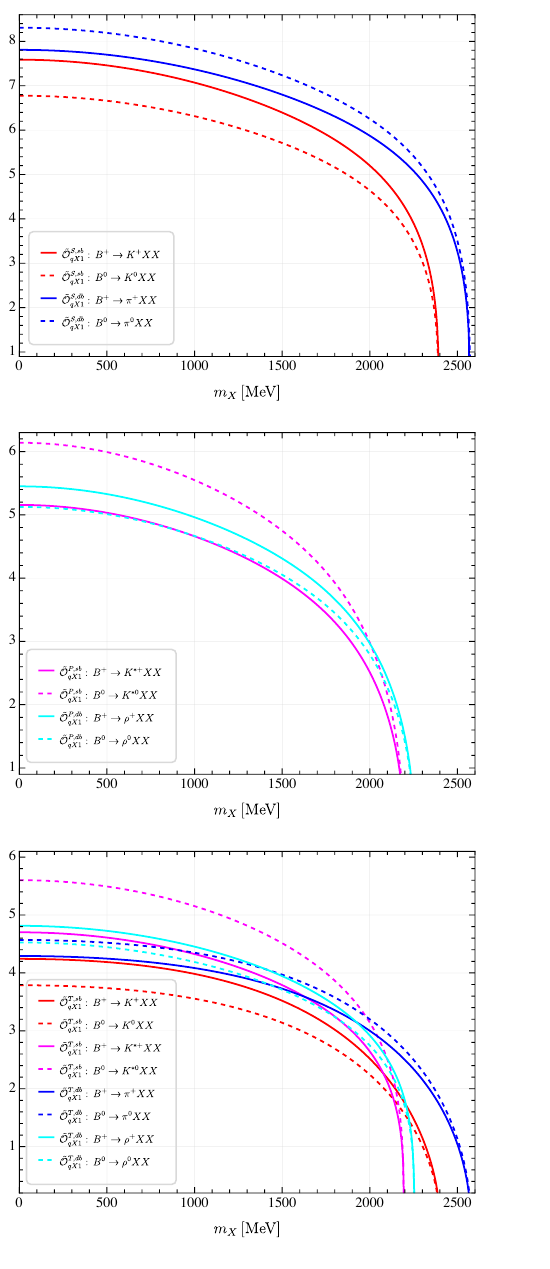
Figure 9 . Constraints on the effective new physics scale for each operator as a function of the DM mass m from B → K ( π ) /E